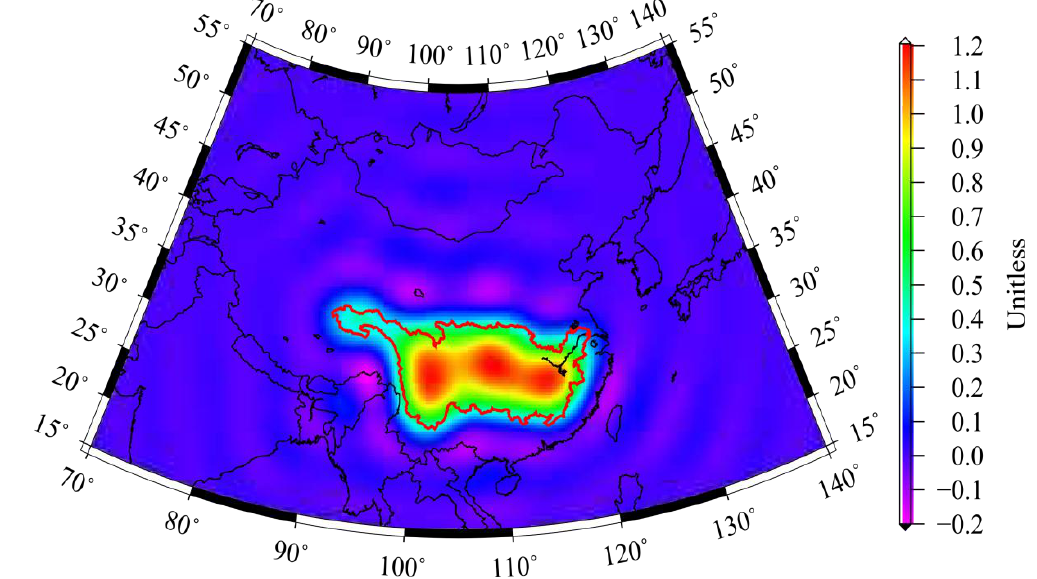
Figure 2. The average function (mask) adopted for the Yangtze basin analysis. The solid red line represents the perimeter of the Yangtze